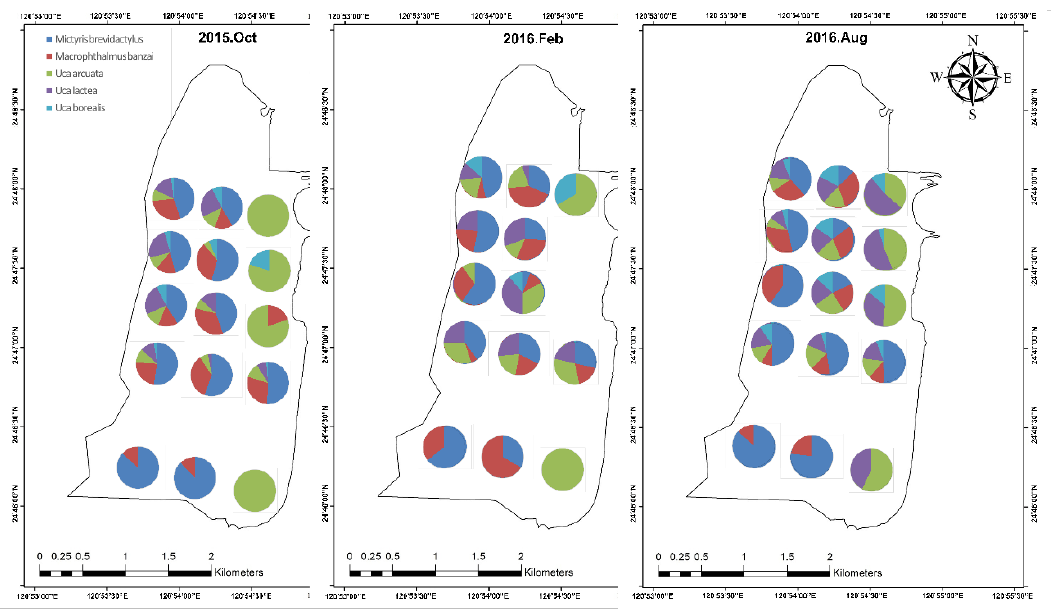
Figure 6. The spatial variation in indicator species with their quantities.